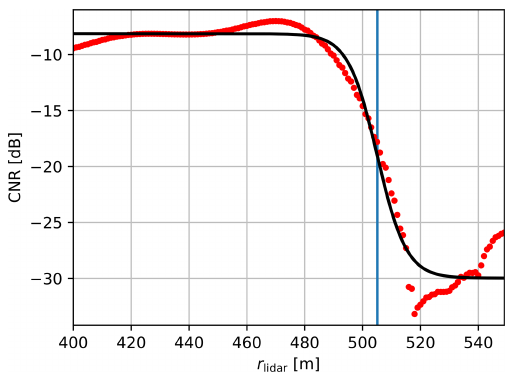
Figure 4. Example of a measured CNR over the range for one az- imuth angle. The black graph is an inverse sigmoid function fitted to the CNR values, and the vertical blue line is in the sigmoid’s midpoint, representing the estimated distance to the sea surface.